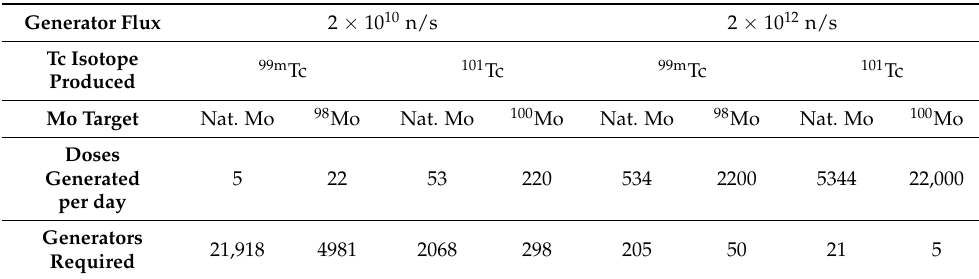
Table 3. Estimated production yields and dose requirements associated with 99m Tc and 101 Tc based on 40,000,000 doses per annum (109,589 doses per day) as a function of generator neutron output and Mo target isotopic composition under continuous operation. A ratio factor of 1:10 99m Tc to 101 Tc was used to estimate doses of 101